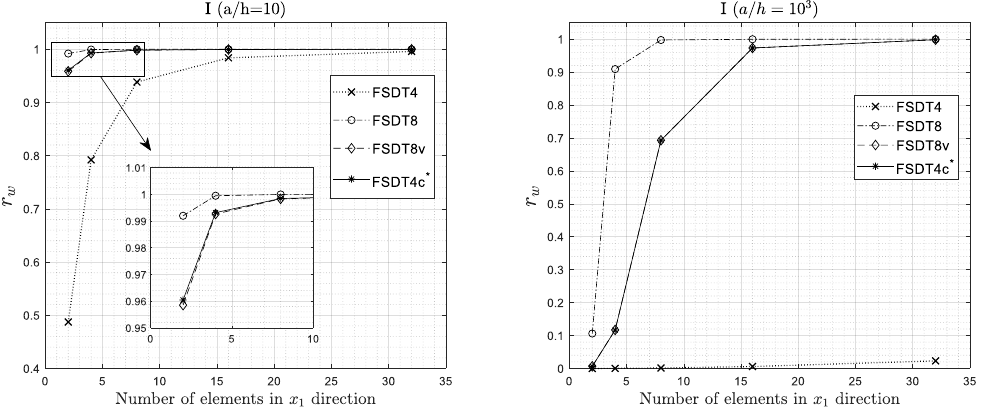
Figure 7. Convergence analysis of the Finite Element Method (FEM) solution for the isotropic plate (I). Regular mesh.